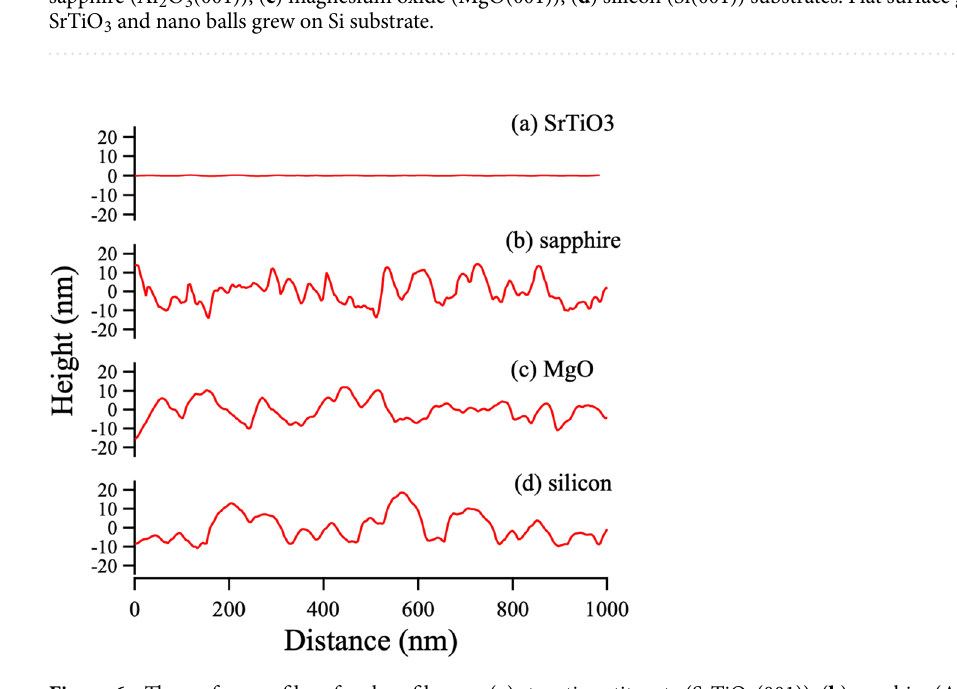
Figure 6. The surface profiles of carbon films on ( a ) strontium titanate (SrTiO 3 (001)), ( b ) sapphire (Al 2 O 3 (001)), ( c ) magnesium oxide (MgO(001)) and ( d ) silicon (Si(001))